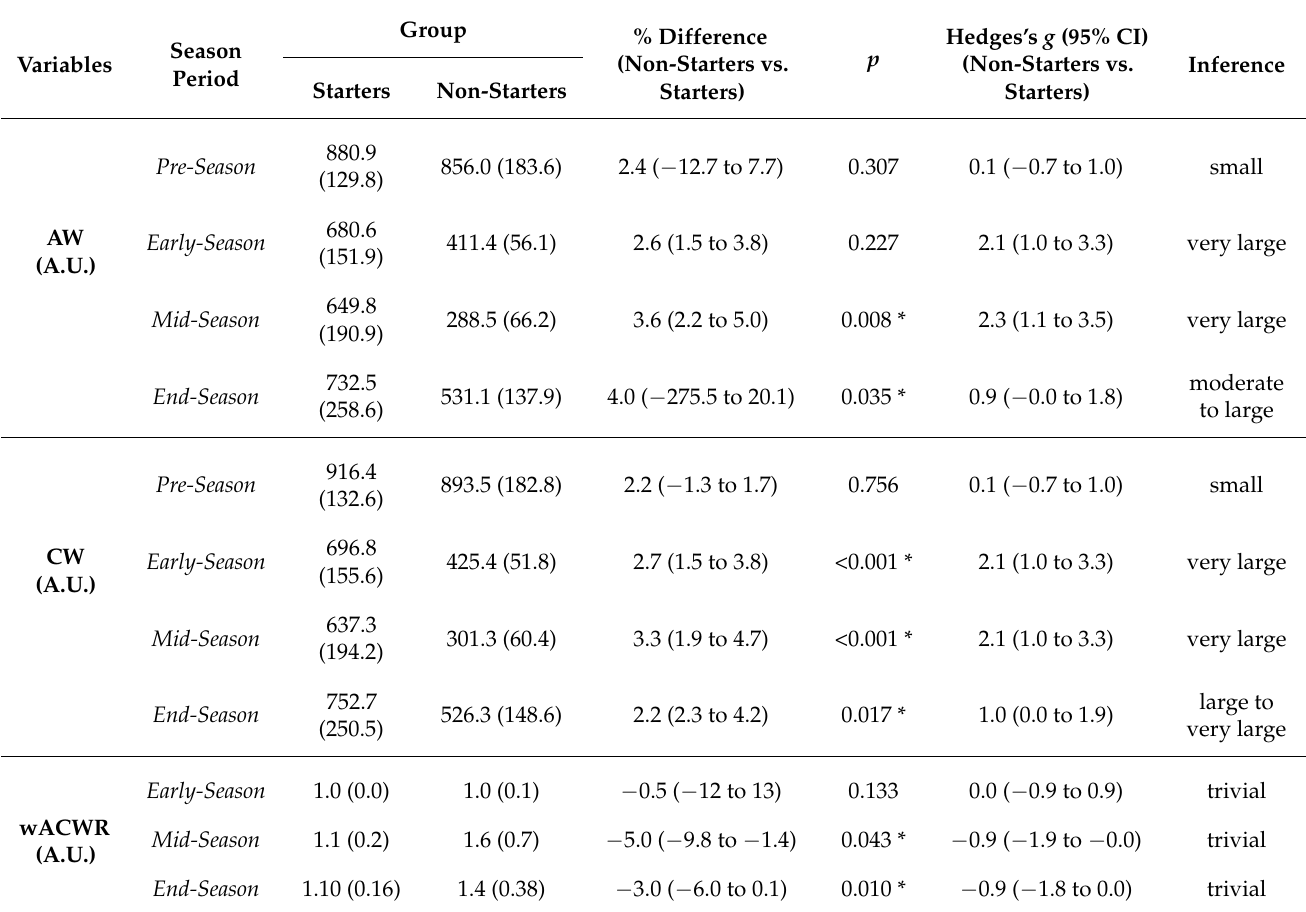
Table 1. Differences between starters and non-starters for AW, CW, and wACWR related to body load in the different periods of the